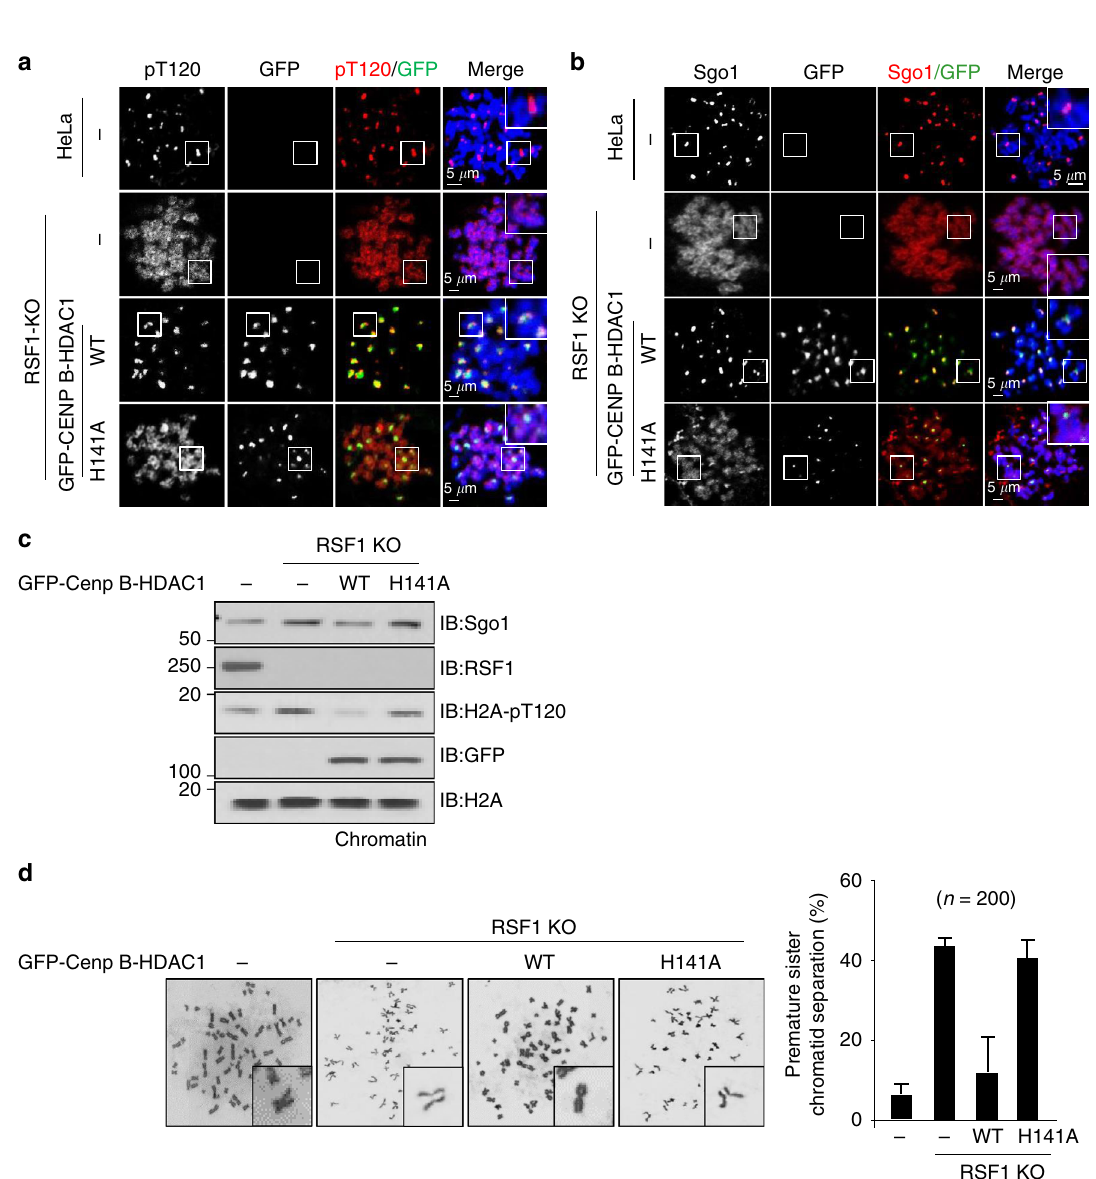
Fig. 5 RSF1-de fi cient cells suffering from sister chromatid cohesion defects are rescued by centromere targeting HDAC1. a RSF1 KO HeLa cells were transfected with centromere targeting GFP-CENP B fused-HDAC1 WT or H141A catalytic dead mutant constructs. Floating mitotic cells were obtained after nocodazole treatment for 4 h and subjected to chromosome spread immunostaining with anti-H2A-pT120 (red) antibodies. Scale bar, 5 μ m. b The cells prepared as Fig. 5a were subjected to chromosome spread immunostaining with anti-Sgo1 (red), and DAPI (blue). Scale bar, 5 μ m. c Immunoblotting of chromatin fractions in RSF1 KO cells after reintroduction of CENP B fused GFP-HDAC1. d Giemsa staining of the metaphase chromosome spreads prepared after transfection of GFP-CENP B fused HDAC1 WT or H141A in RSF1 KO cells. Left panel shows quanti fi cation of the percentage of premature sister chromatid